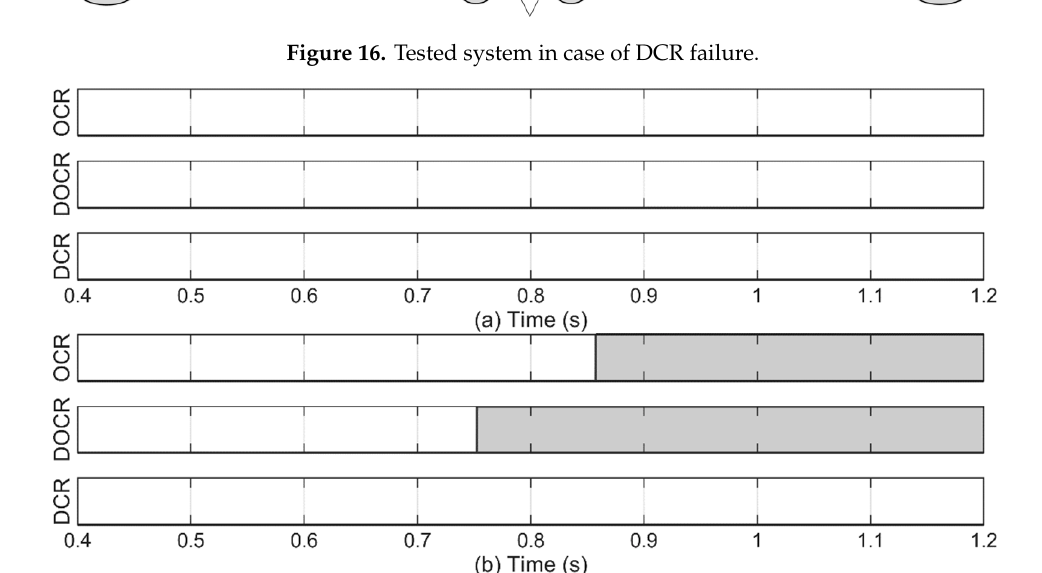
Figure 17. Relay trip signals in case DCR fails: ( a ) relays in HTS 1 ; ( b ) relays in HTS 2 . Energies 2020 , 13 , x FOR PEER REVIEW